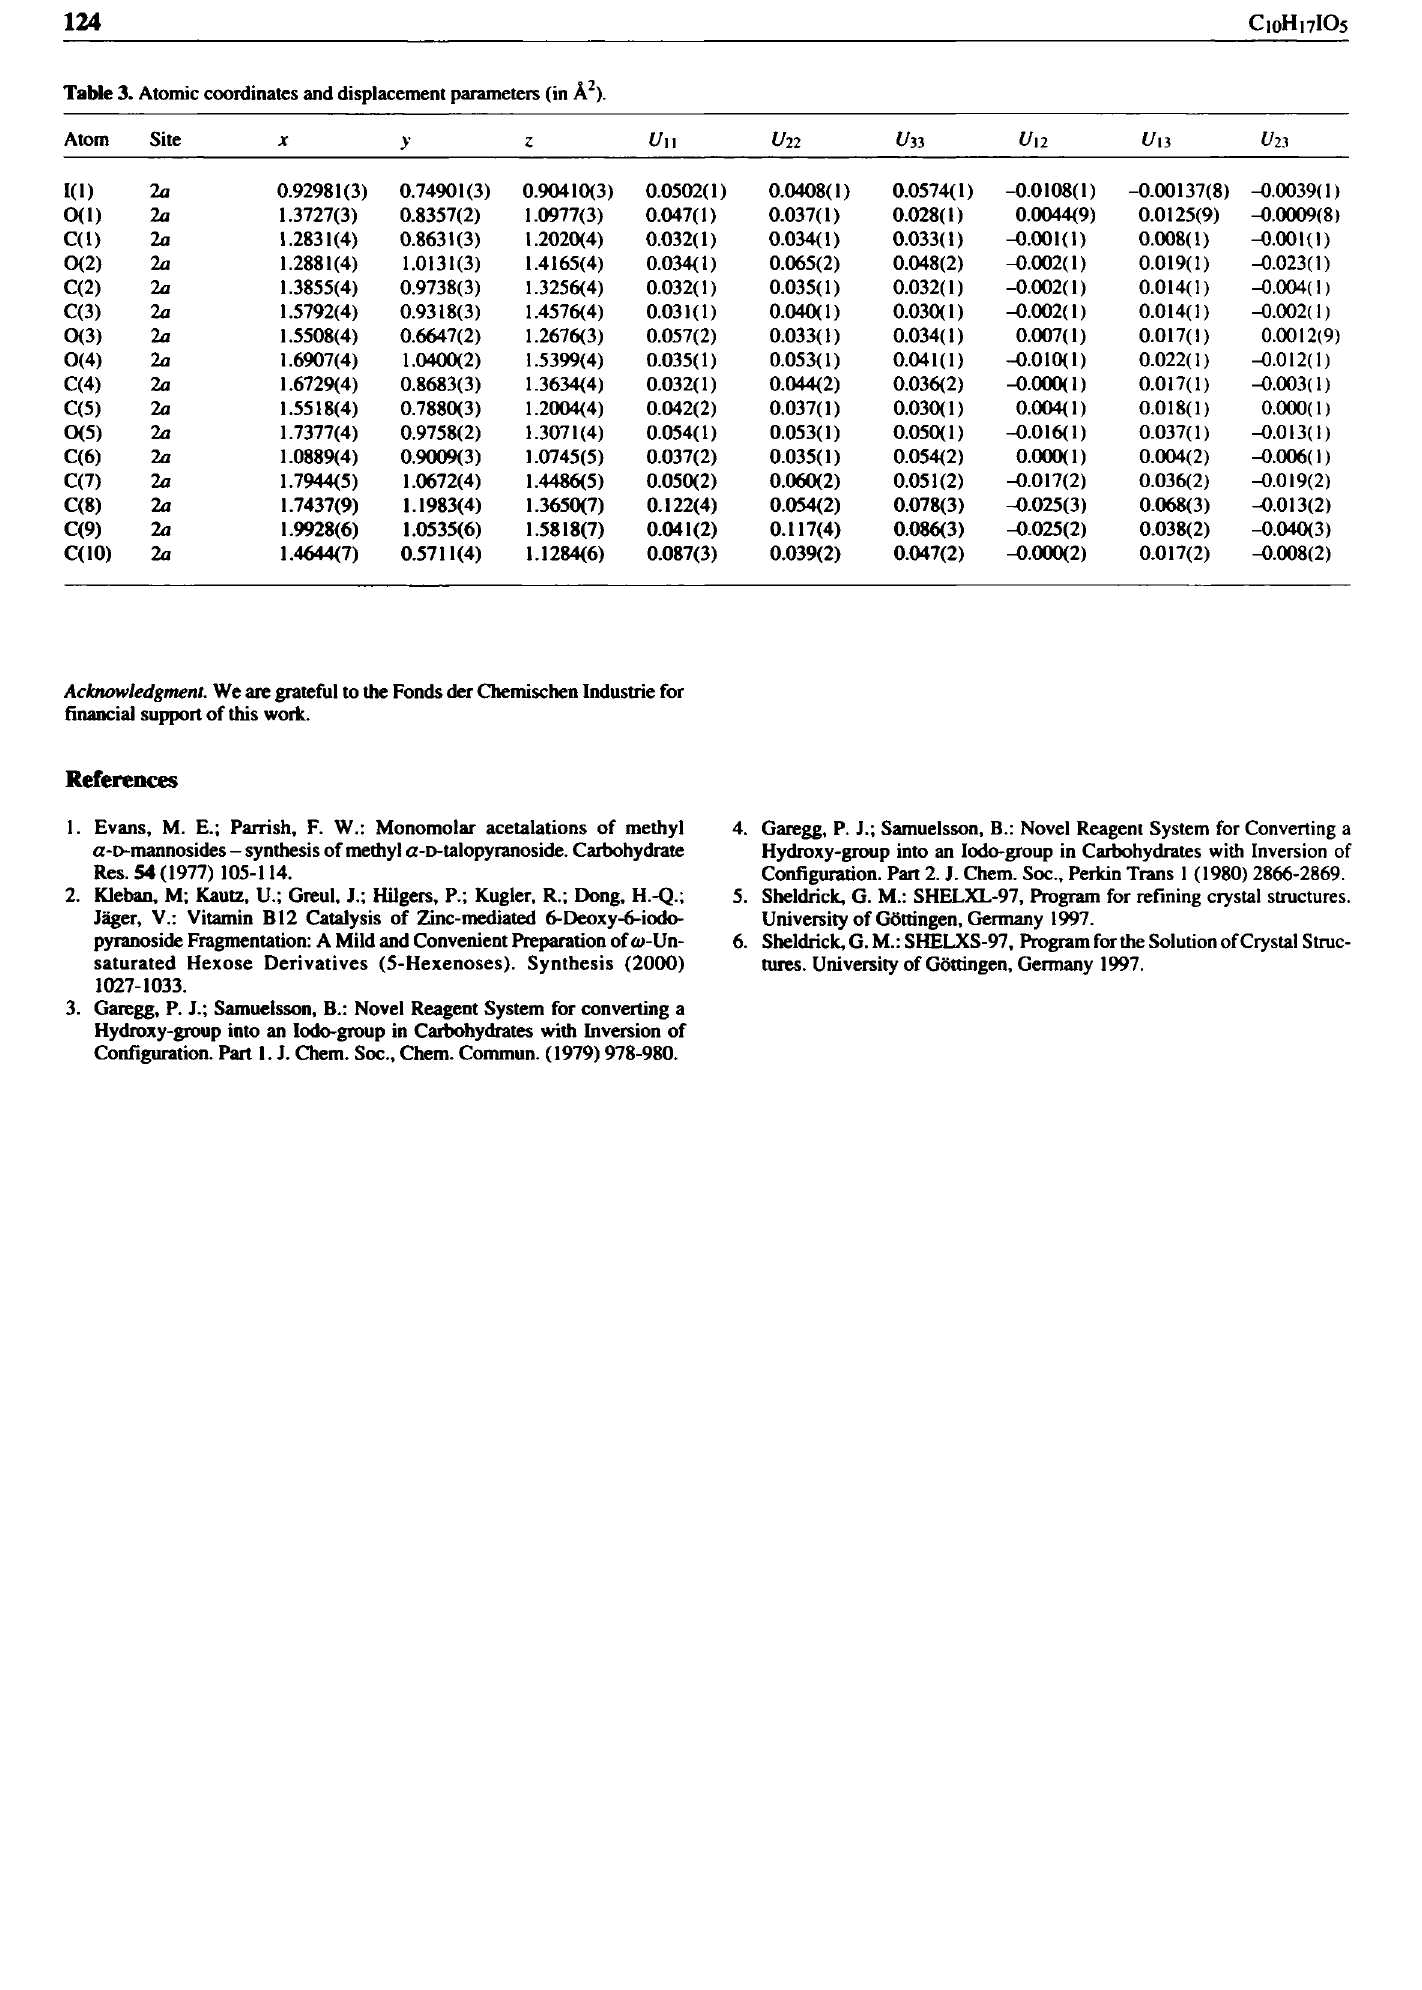
Table 3. Atomic coordinates and displacement parameters (in Â 2